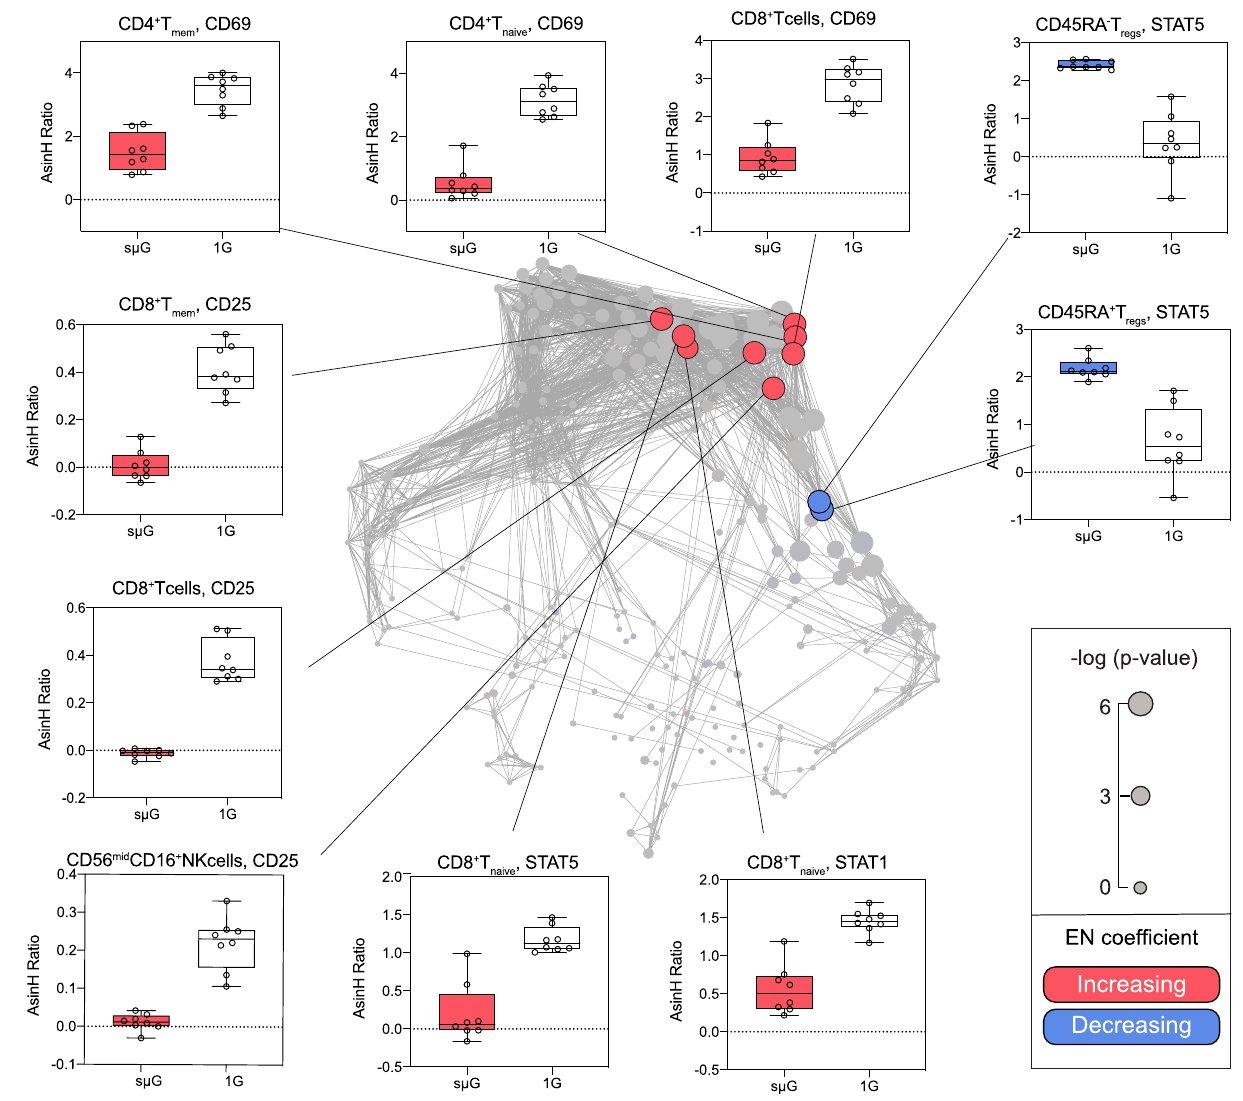
Figure 4. EN Model components reveal cell-specific immunosuppressive effect of sµG on innate and adaptive immune cell subsets. Center. EN model components are visualized on the correlation network. Blue/red color scheme indicates increased/decreased EN component (respectively) in the sµG vs. the 1G condition. Sizes of nodes correspond to -log ( p value) (Wilcox signed rank test, n = 8). Periphery. Box plots depicting major EN model components (AsinH Ratio of the stimulated samples compared to unstimulated samples). Additional model components are listed in Table